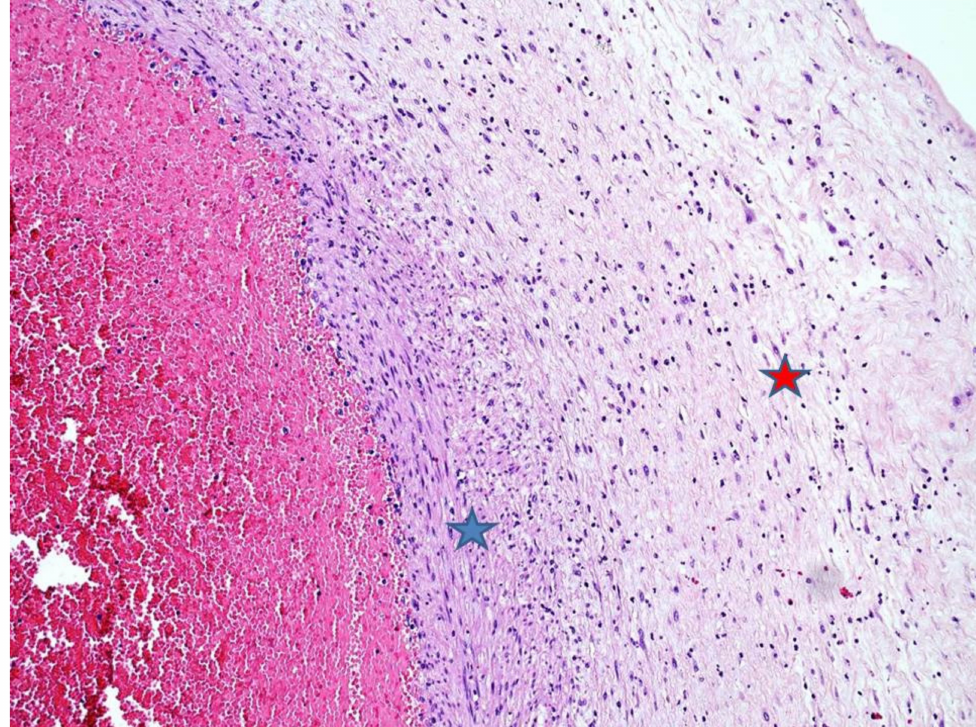
Figure 4. Umbilical artery acute vasculitis: Neutrophils within the arterial wall (blue star) with extension to Warthon’s jelly (red star) (HE staining, 4 ×